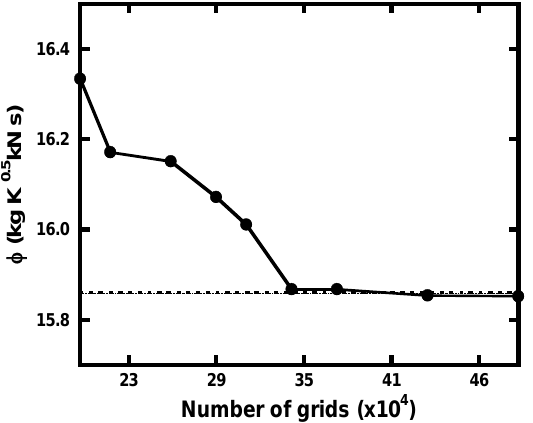
Figure 4. Example of grid test results of the ribbed seal.